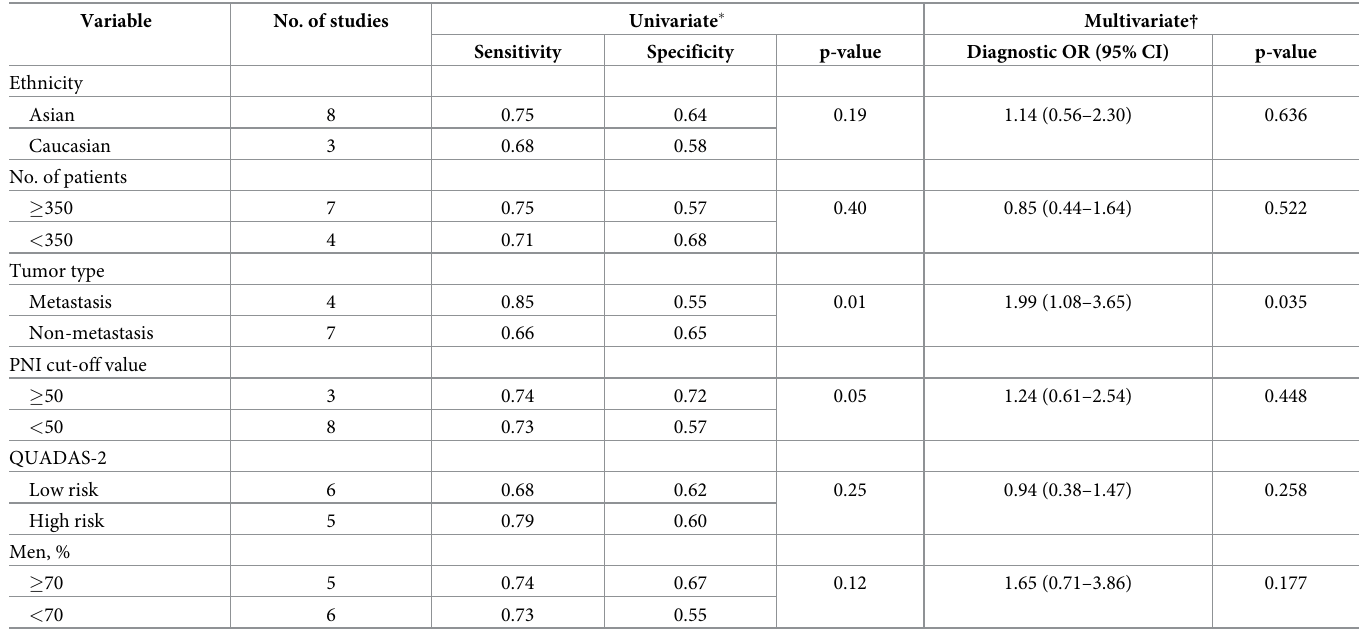
Table 2. Univariate and multivariate meta-regression analysis for identifying potential sources of heterogeneity in the diagnostic performance of screening